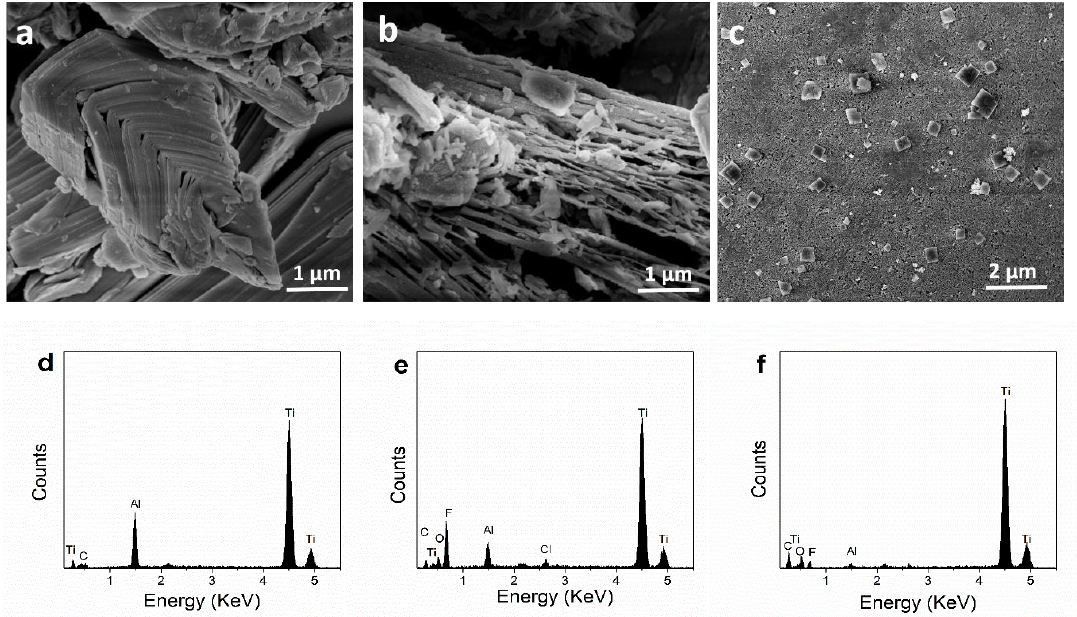
Figure 1. Scanning electron microscopy (SEM) images of: ( a ) Ti 3 AlC 2 , ( b ) multilayered (ML)-Ti 3 C 2 T x , and ( c ) delaminated single-layered (SL)-Ti 3 C 2 T x . Energy-dispersive X-ray spectrometer (EDS) spectra of ( d ) Ti 3 AlC 2 , ( e ) multilayered ML-Ti 3 C 2 T x , and ( f ) delaminated SL-Ti 3 C 2 T x.